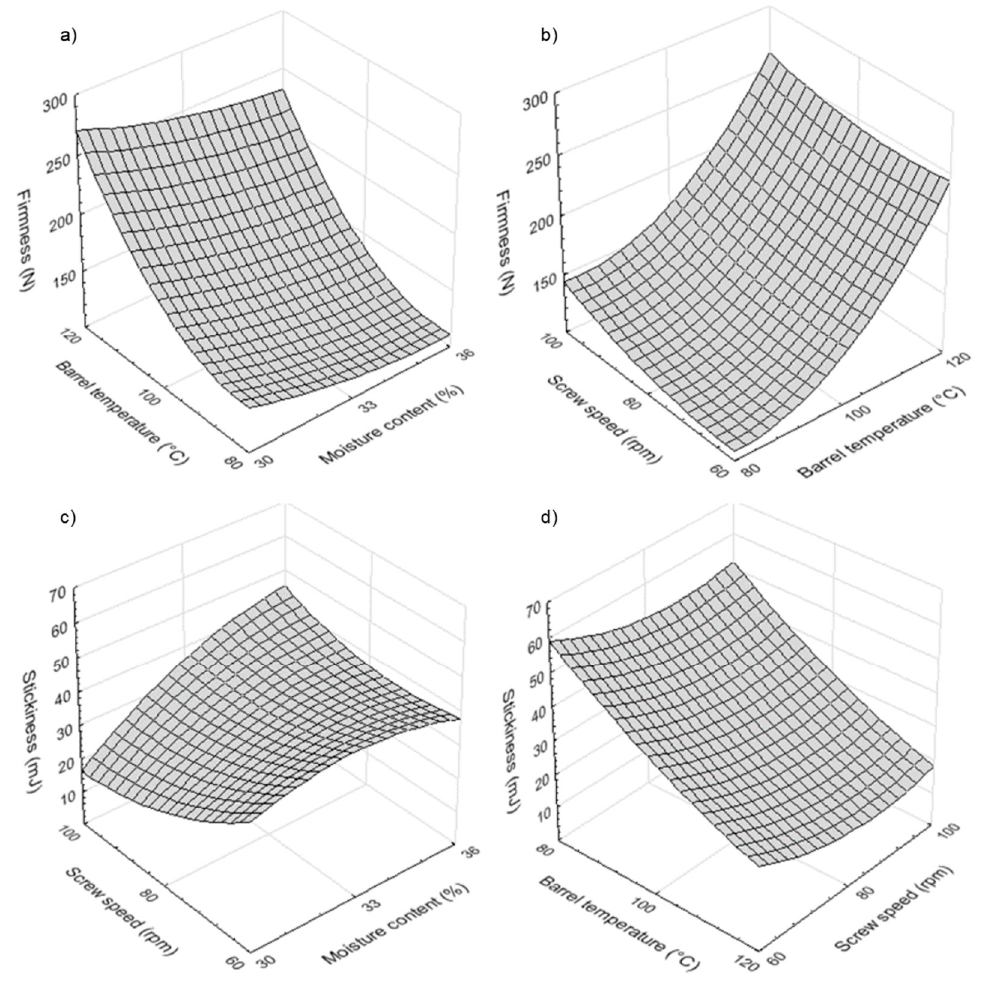
Figure 3. E ff ect of moisture content, barrel temperature and screw speed on ( a , b ) firmness and ( c , d ) Figure 3. Effect of moisture content, barrel temperature and screw speed on ( a and b ) firmness and ( c stickiness of hydrated rice-buckwheat and d ) stickiness of hydrated rice-buckwheat pasta.